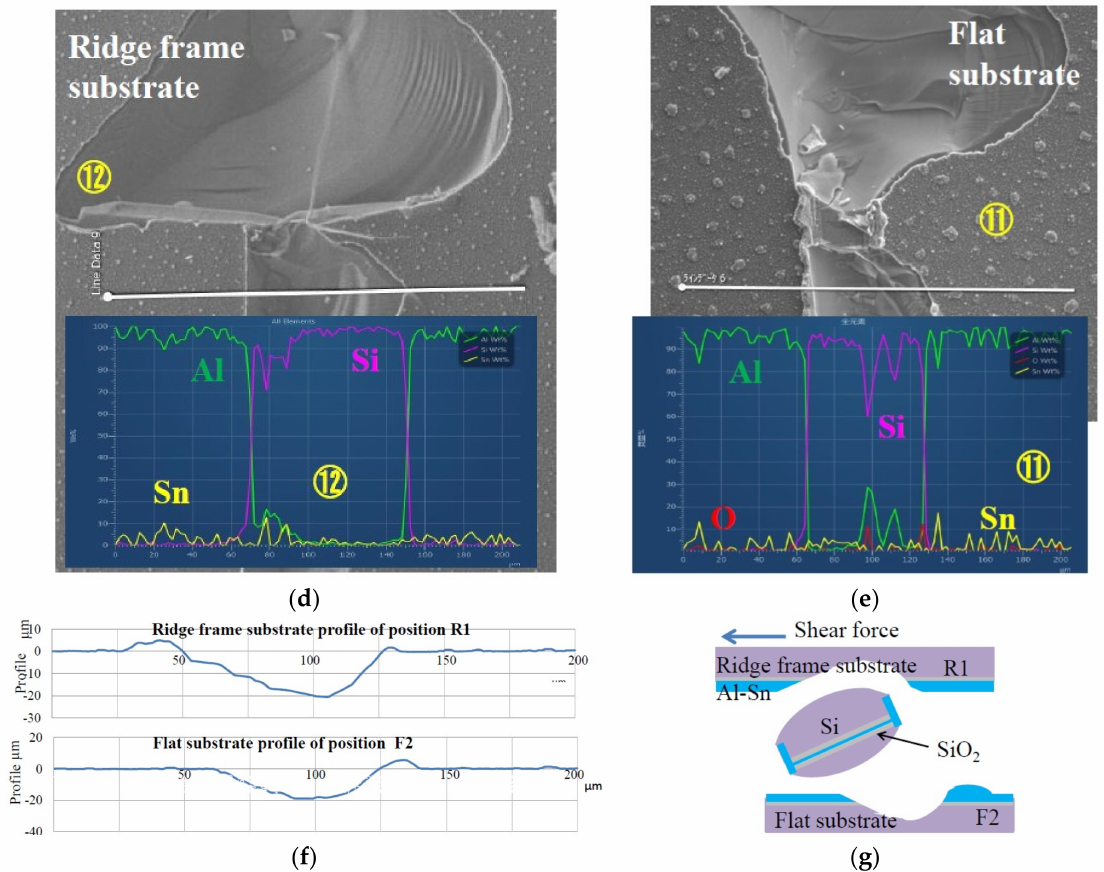
Figure 7. Results of EDX, SEM, and surface profile measurements of shear-fractured dies which showed shear fracture strength of 130 MPa. ( a ) Surface photograph of ridge frame substrate. ( b ) Surface photograph of flat substrate; ( c ) Surface photograph and EDX results of central right part of ( a ) and central left part of ( b ); ( d ) SEM and EDX results of ridge frame substrate; and ( e ) SEM and EDX results of flat substrate; ( f ) Surface profiles of shear-fractured positions R1 and F2; ( g ) Schematic cross section of shear-fractured positions R1 and